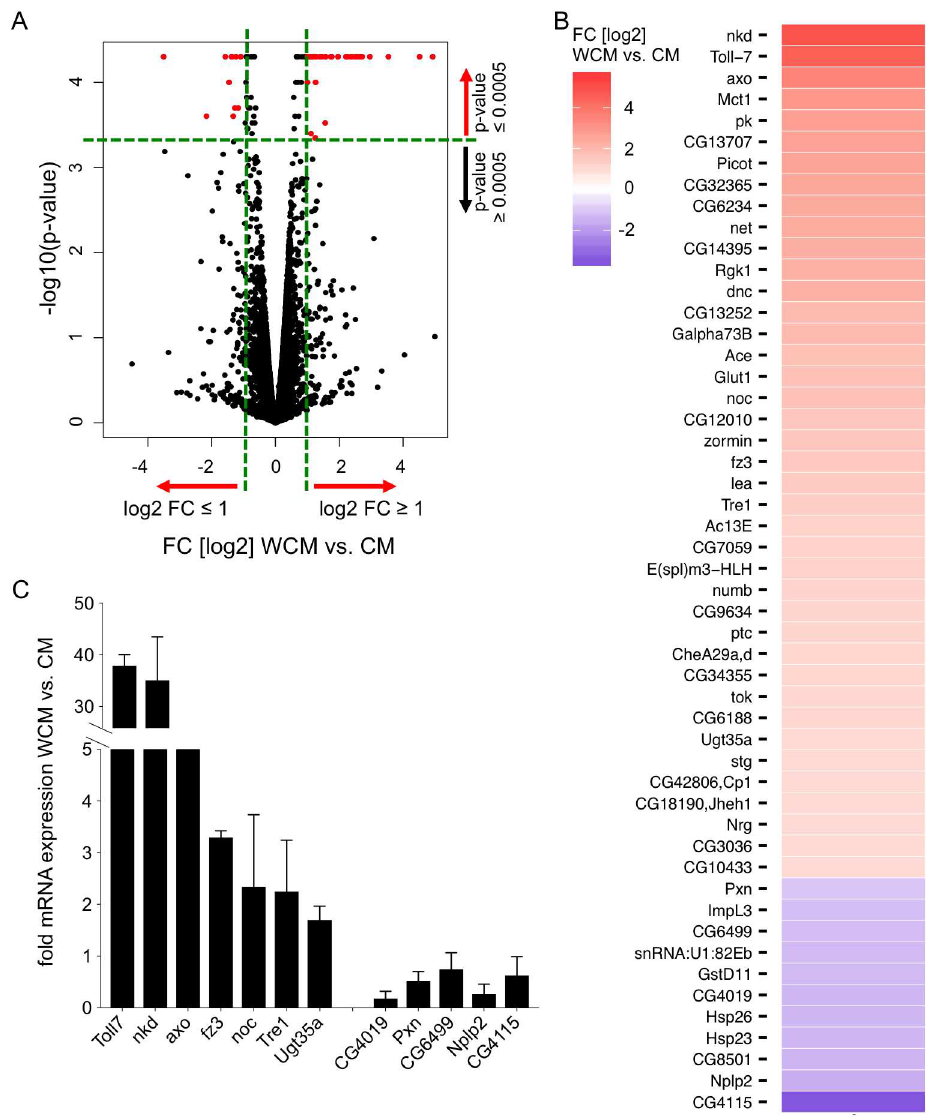
Fig 1. Identification of Wnt/Wg-responsive genes. (A) Volcanoplot showingthe log2 fold change(x-axis) and statistical significance(y-axis; -log10p-value)of Wnt/Wg-responsivegenes. 51 genes were significantly differently expressedafter WCM-treatment (red dots), 40 genes showedan up-regulation (positivetargets), 11 geneswere down-regulated(negativetargets) after WCM treatment. Black dots represent all genes that showedan altered expressionprofile. (B) Heatmap showingthe log2 fold change (FC) of expressionof the 51 Wnt/Wg-responsivegenesin wild-typecells (WT). The expressionprofile of positive target genes is depicted in red, the expressionprofile of negativetargets is in blue. (C) Confirmingof candidate genesusing qRT-PCR. Drosophila Kc cells were stimulated with WCM or CM for 24 h. Analysis of expressionprofiles of candidate target genes(7 positive and 5 negative)after treatment versus control confirmed their inductionafter WCM stimulation. cuticle ( nkd ), CG6234 , frizzled 3 ( fz3 ) and Peroxidasin ( Pxn ) [34–36, 20], confirming our quality filters. 40 genes were at least two fold up-regulated (positive targets) and 11 genes two fold down-regulated (negative targets) (Fig 1B). 7 positive and 5 negative candidate target genes were confirmed by qRT-PCR (Fig 1C). This high confidence set of Wnt/Wg target genes was